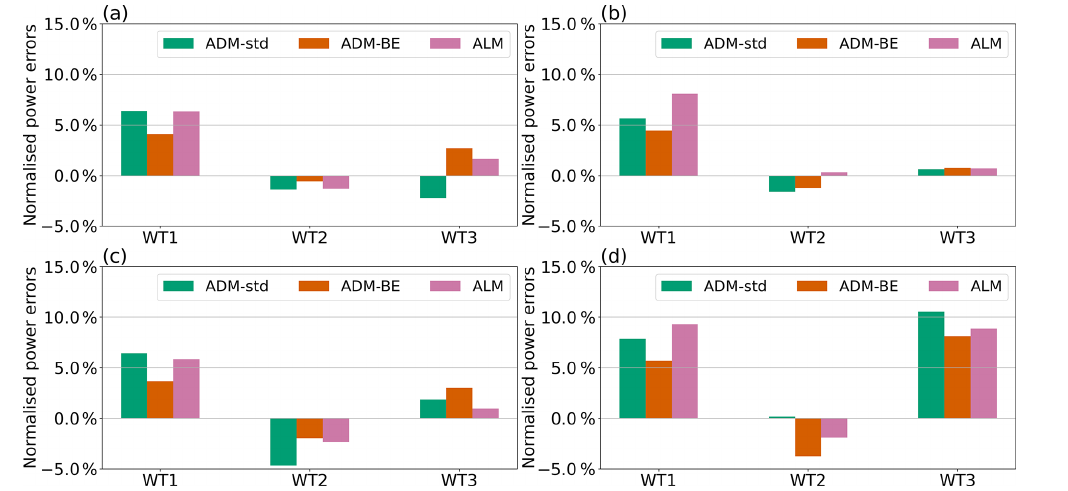
Figure 15. Normalised power errors in (a) Case 1: γ = (0 , 0 , 0 ◦ ), zero offset; (b) Case 2: γ = (25 , 15 , 0 ◦ ), zero offset; (c) Case 3: γ = (0 , 0 , 0 ◦ ), D/ 3 offset; (d) Case 4: γ = (20 , 20 , 0 ◦ ), D/ 3 offset. The power outputs are normalised by the measured power of the zero-yawed first turbine of the turbine array.